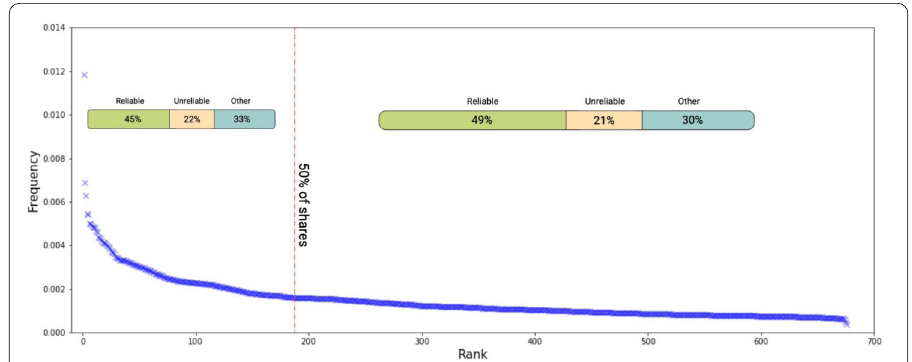
Figure 8 Frequency of the URLs as a function of the ranking, where ranking = 1 is assigned to the most retweeted URL in the dataset. The distribution is highly heavy-tailed with 186 out of 700 URLs to the left of the red line accounting for 50% of the total URL shares. The coloured bars represent the distribution of reliable, unreliable, and other (i.e., unlisted) URLs. Only reliable and unreliable URLs contribute to the computation of